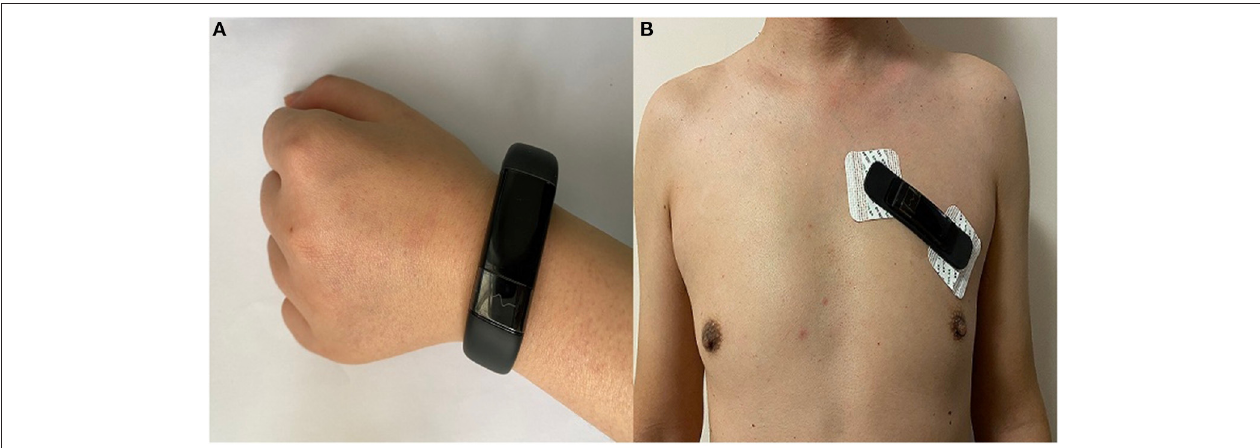
FIGURE 1 | AMAZFIT ® location diagram. (A) : wrist (B) : chest wall.